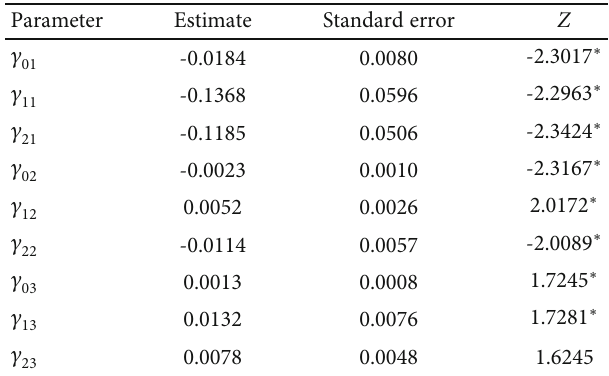
Table 4: Parameter estimates, standard errors, and statistical test values of the partial test for the GWMLR model of Lamandau